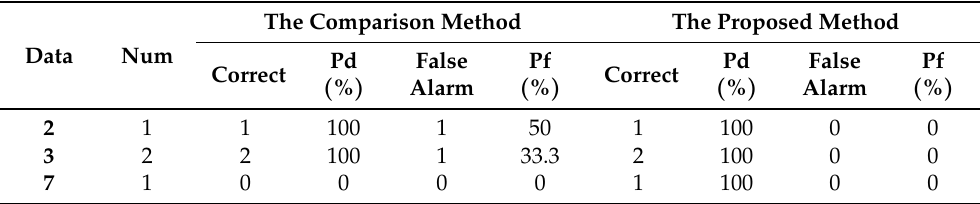
Table 5. Comparison of the bridge detection results between the proposed method and the spatial